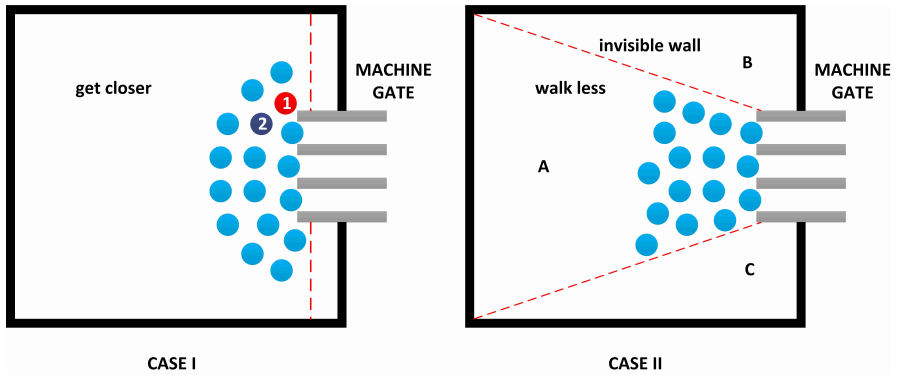
Figure 1. Two cases of pedestrian movement.